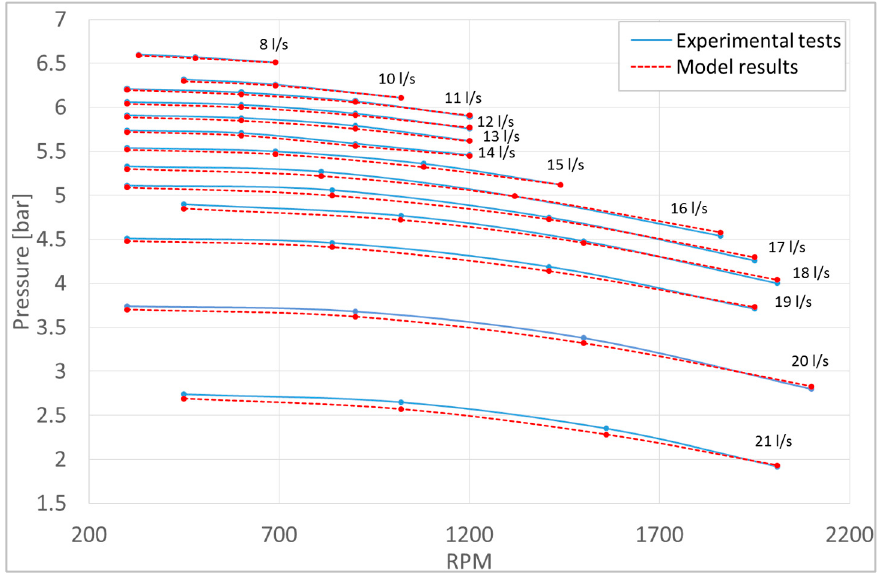
Figure 7. Experimental results. ( a ) Head; ( b ) Efficiency.